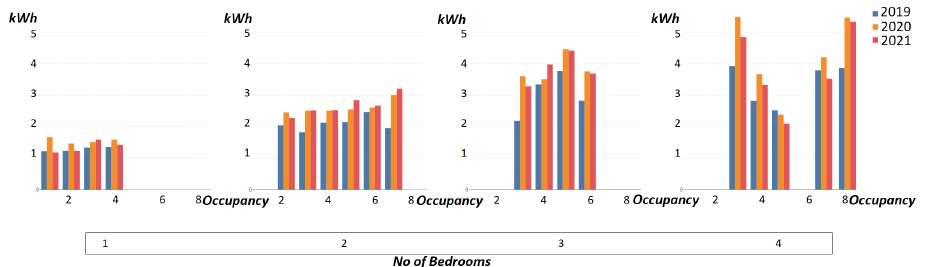
Figure 15. Mean consumption vs. occupancy in bedrooms in April over 3 years for the ‘AC-included’